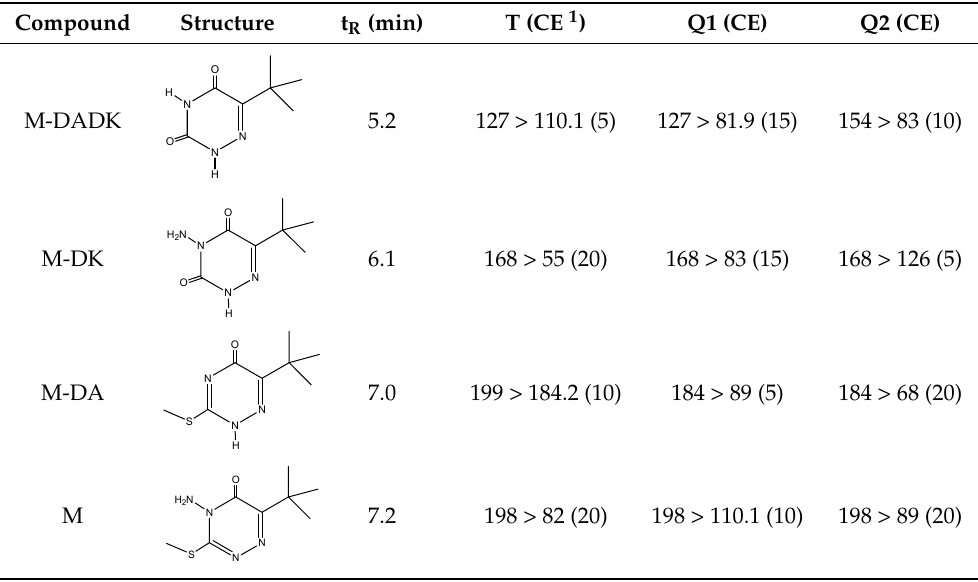
Table 1. Retention time (t R ), chemical structure, and target (T), and qualifier transitions (Q1 and Q2) of metribuzin (M) and its three metabolites.